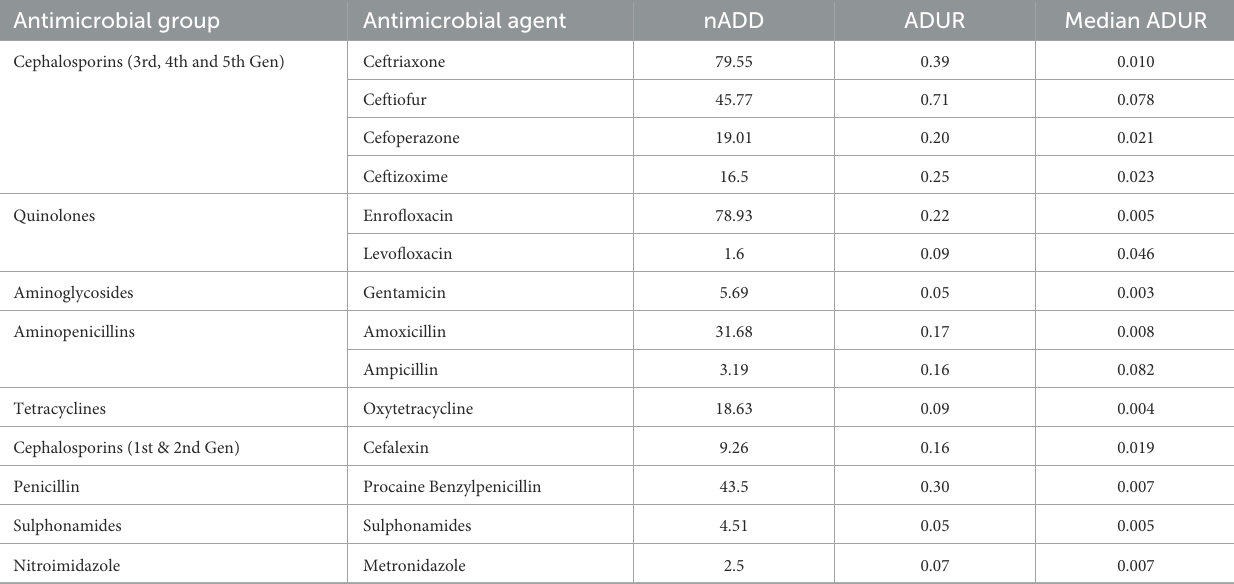
TABLE 4 ADUR (i.e., ADD/1000 animal-days) of various groups of antimicrobials in the selected dairy herds. Antimicrobial